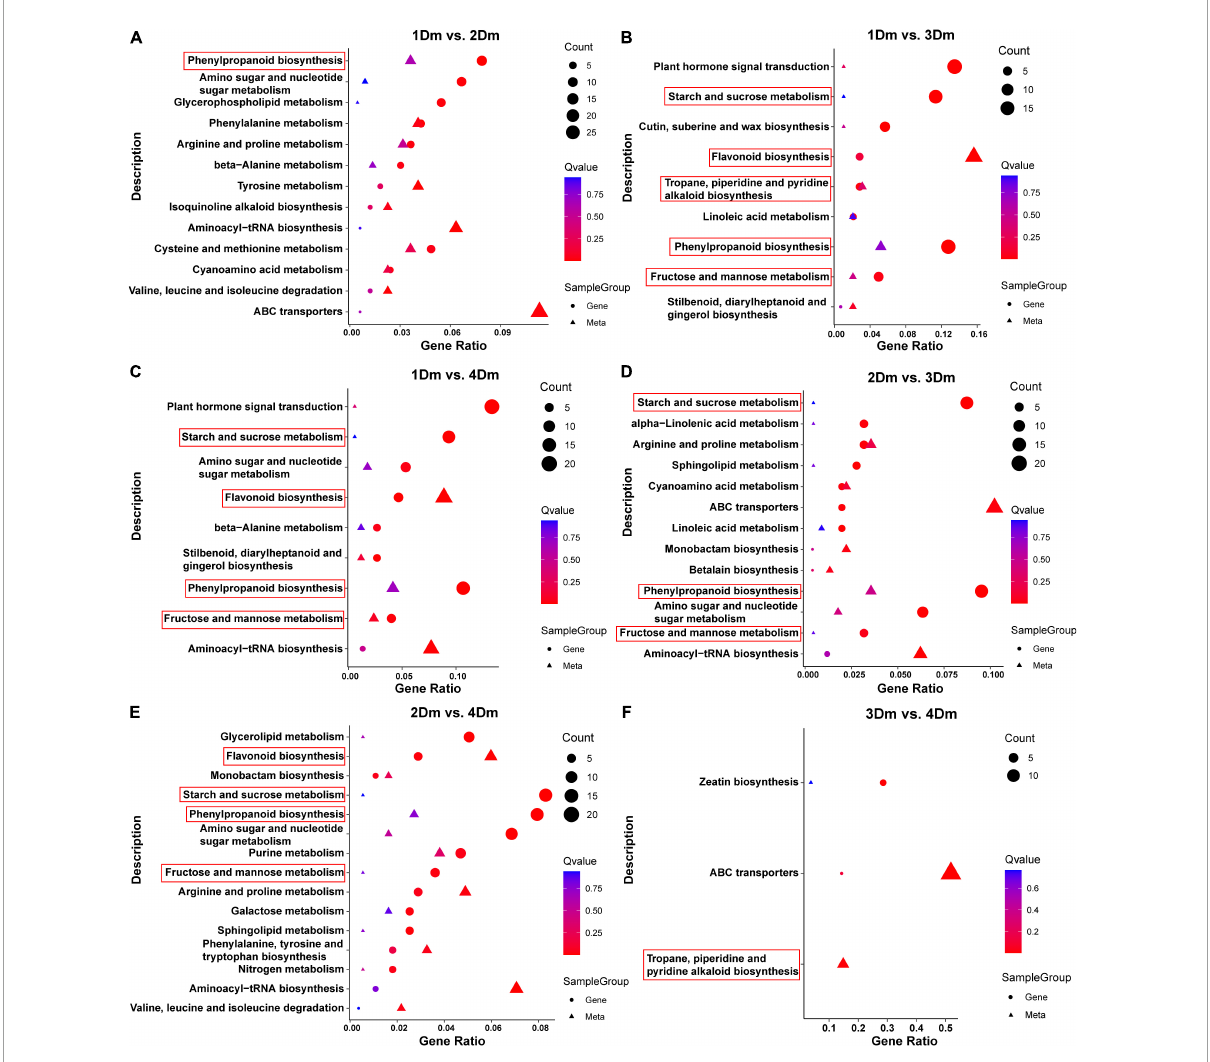
FIGURE4 Scatterplot of KEGG pathway enrichment for transcriptome and metabolome. The circles indicate genes and the triangles indicate metabolites. The horizontal axis is the gene ratio and the vertical axis is the pathway terms. The larger the point, the greater the number of DEGs or DAMs involved. The pathways related to flavonoid, polysaccharide and alkaloid biosynthesis are marked with red boxes. (A) 1Dm vs. 2Dm; (B) 1Dm vs. 3Dm; (C) 1Dm vs. 4Dm; (D) 2Dm vs. 3Dm; (E) 2Dm vs. 4Dm; (F) 3Dm vs.